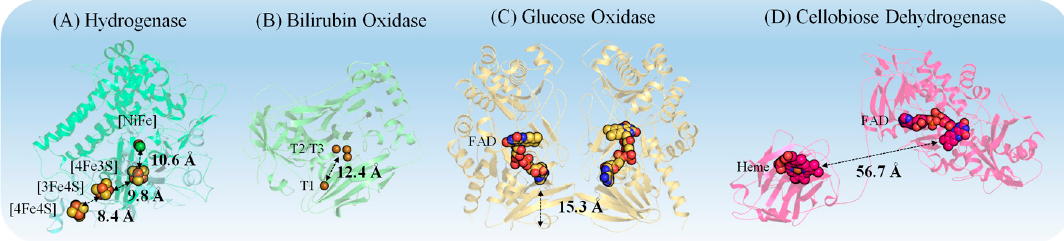
Figure 3. Representation of relevant distances for intramolecular and interfacial ET in several redox enzymes: metal center to metal center, metal center to cofactor, or cofactor to protein surface. ( A ) A. aeolicus hydrogenase model [31]; ( B ) Bilirubin oxidase (pdb ID: 2XLL); ( C ) Glucose oxidase (pdb ID: 1CF3); ( D ) Cellobiose dehydrogenase (pdb ID: 4QI7).